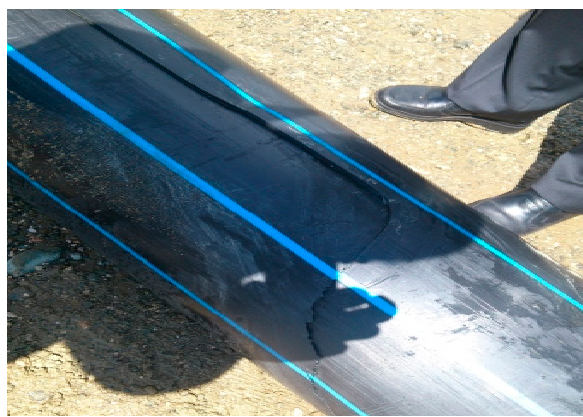
Figure 25. Brittle crack of pipe (photo Scarlatescu).